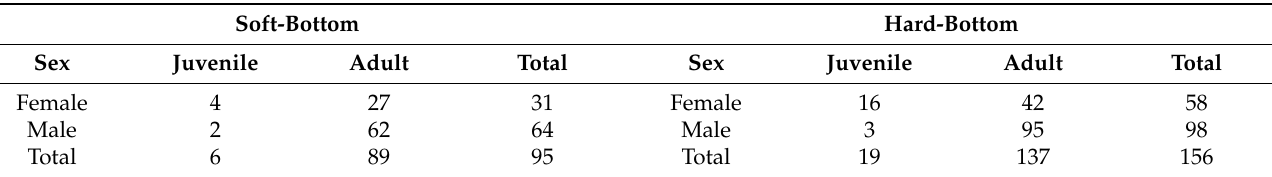
Table 1. Distribution of analysed long-tailed duck numbers across age groups, sex, and seabed type at the bycatch sites during years from 2016 to 2020. Soft-Bottom